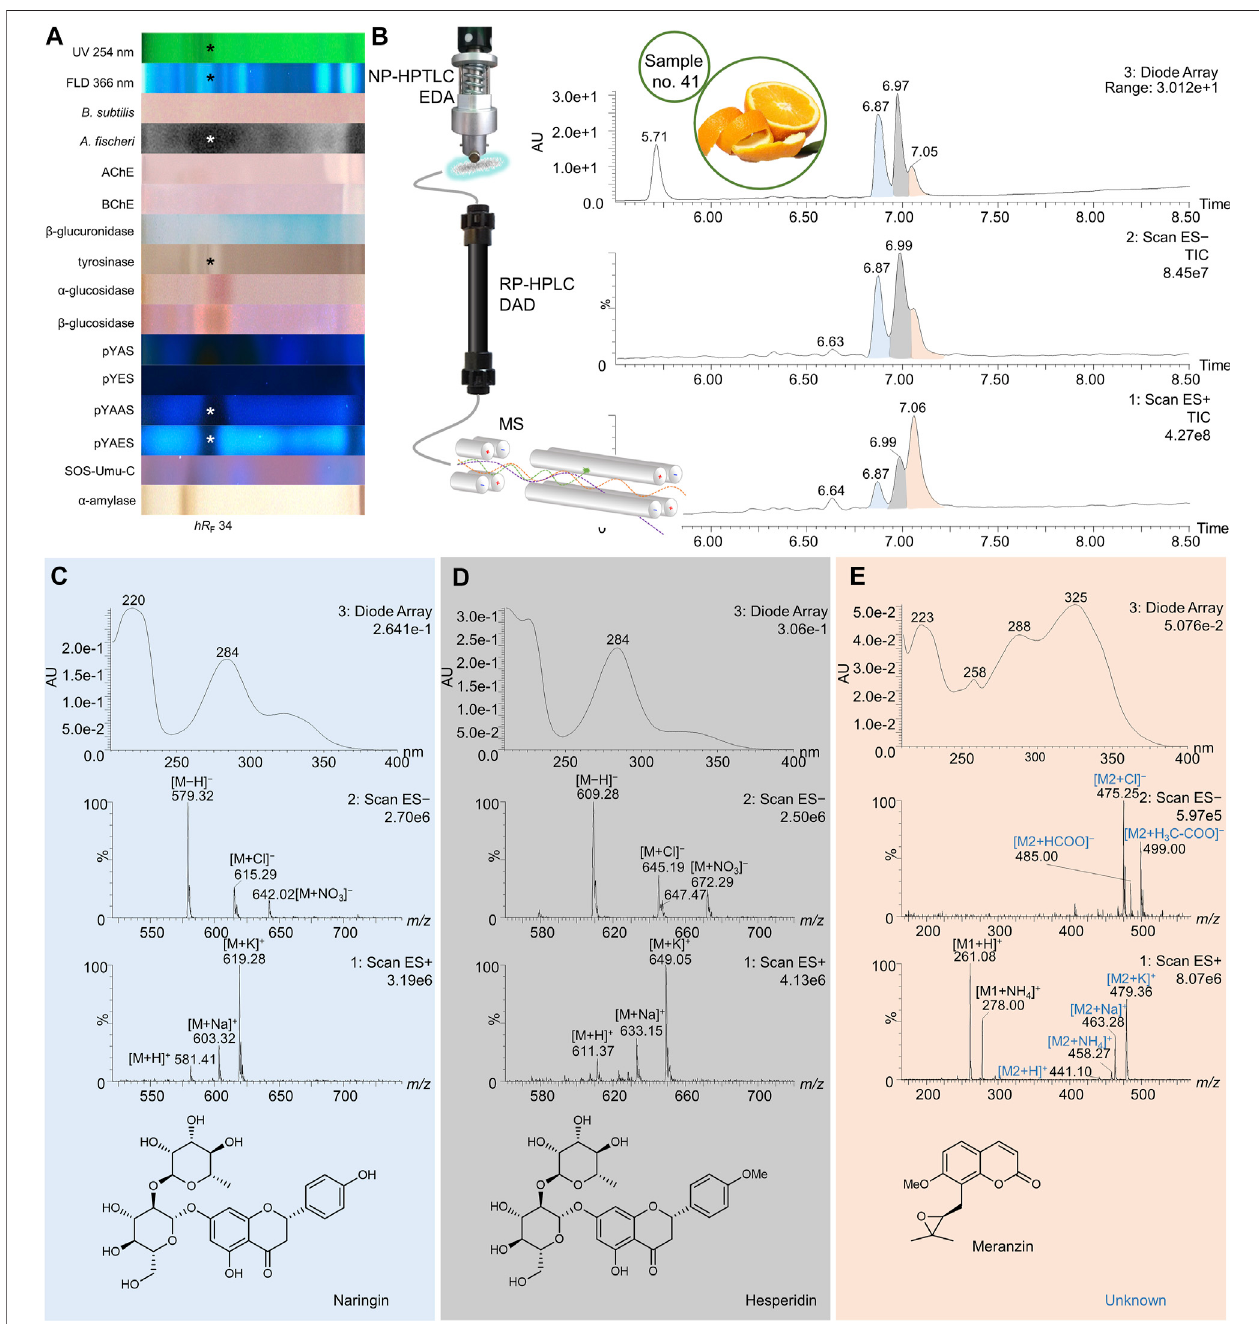
FIGURE 7 | NP-HPTLC − UV/Vis/FLD − EDA − heart-cut RP-HPLC − DAD − HESI-MS analysis of orange peel no. 41. NP-HPTLC − UV/Vis/FLD − EDA analysis as in Figure 3 (A) , followed by heart-cut elution of the bioactive zone at hR F 34 (marked*) directly out of the pYAES bioautogram and online desalting to obtain the RP- HPLC − DAD − HESI-MS chromatograms (B) and respective UV and mass spectra of the peaks at RT 6.87 min (C) , 6.98 min (D) , and 7.05 min (E) .